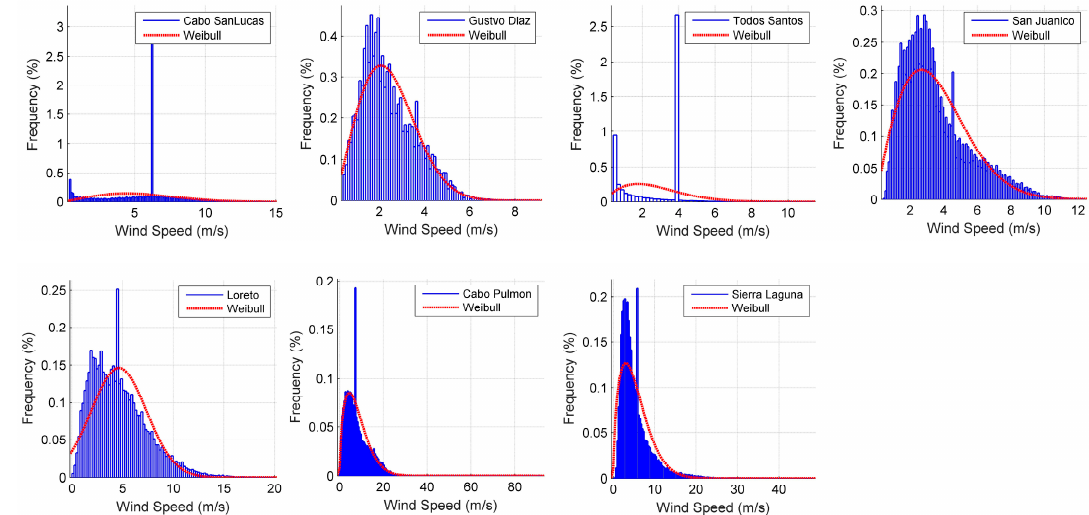
Figure 5. Weibull function at AMSs at Baja California Sur.